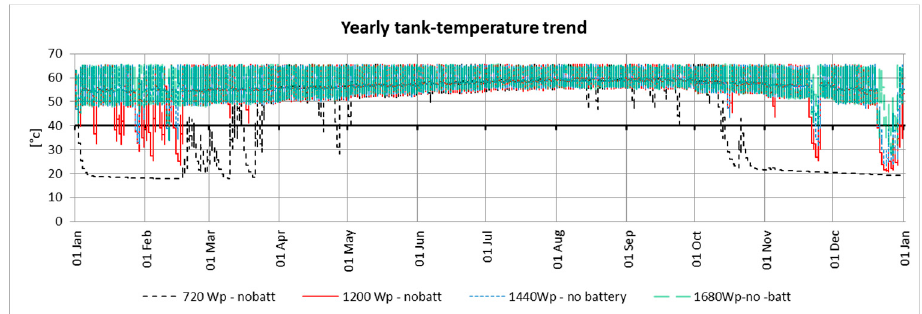
Figure 12. Temperature trend with reference to comfort limit.